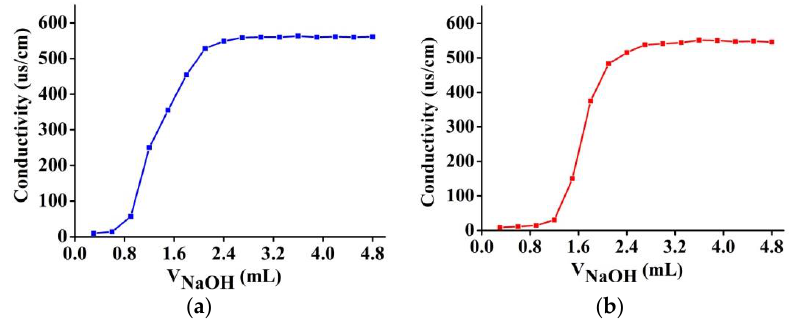
Figure 5. Conductometric titration curves of ( a ) MIP; and ( b ) NIP.